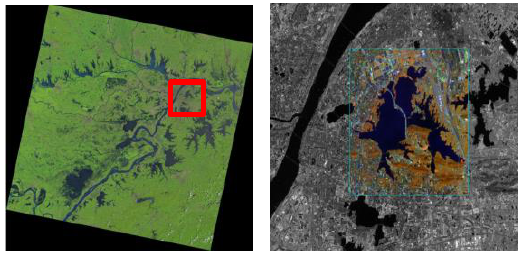
Figure 2. Location of lake Donghu in Landsat image